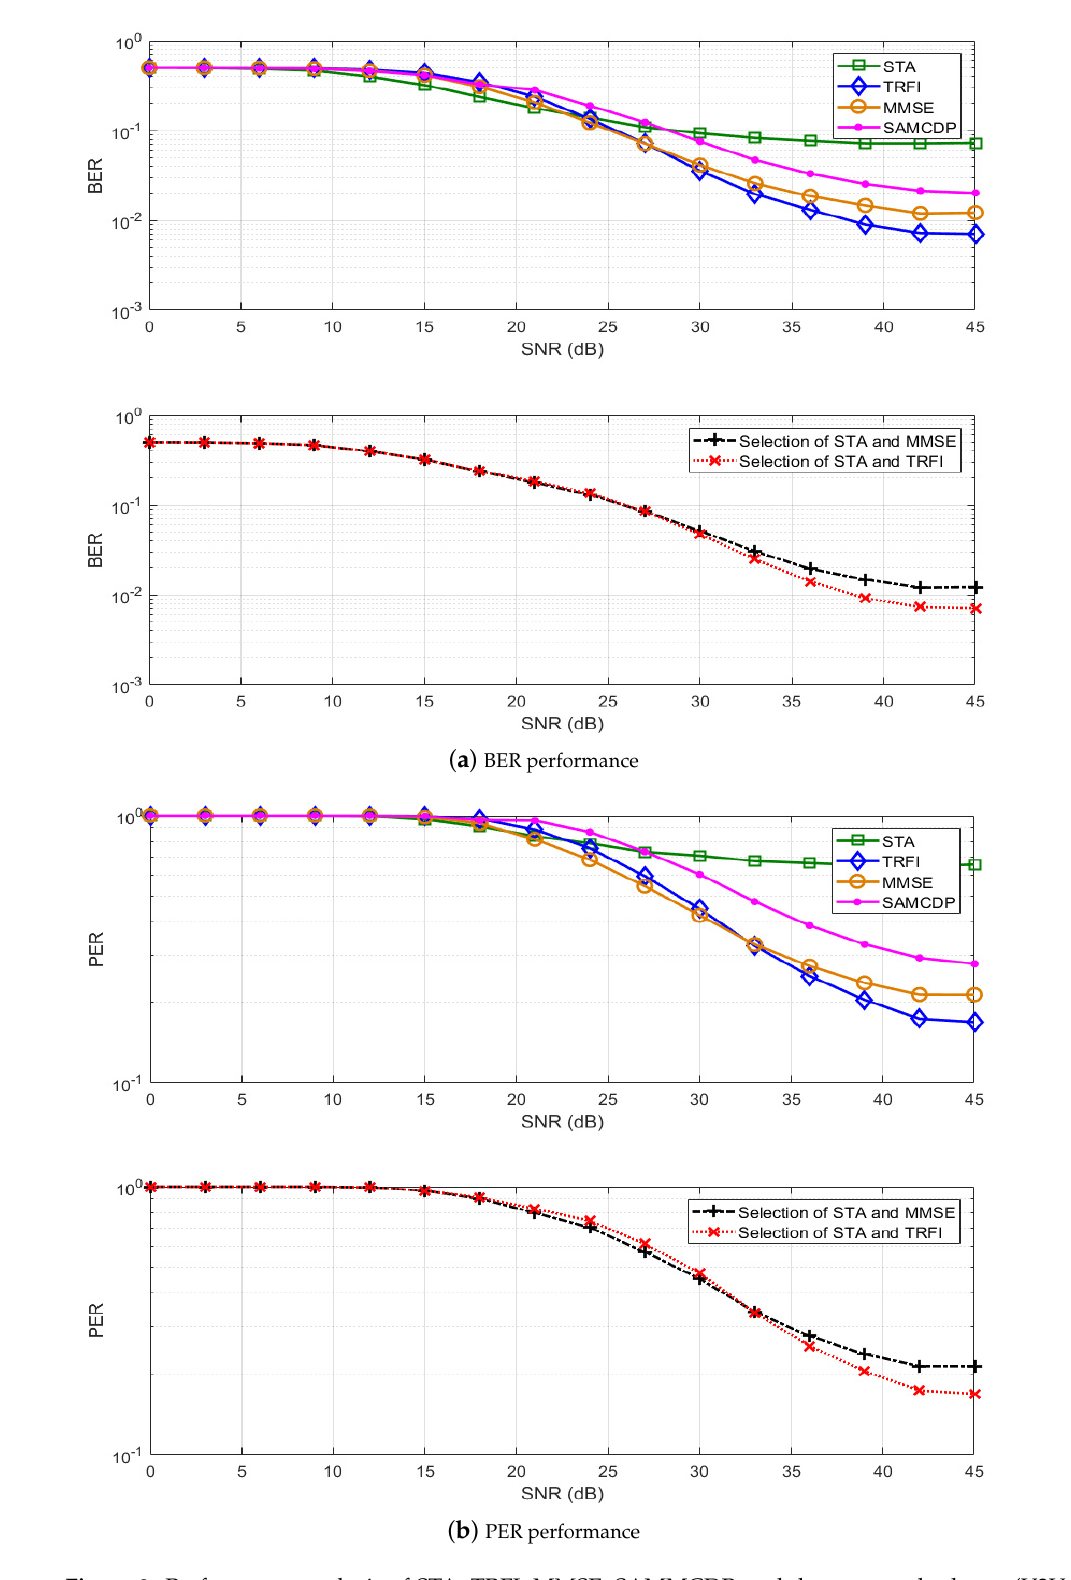
Figure 8. Performance analysis of STA, TRFI, MMSE, SAMMCDP, and the proposed scheme (V2V Expressway Oncoming, 16QAM 1/2, 50